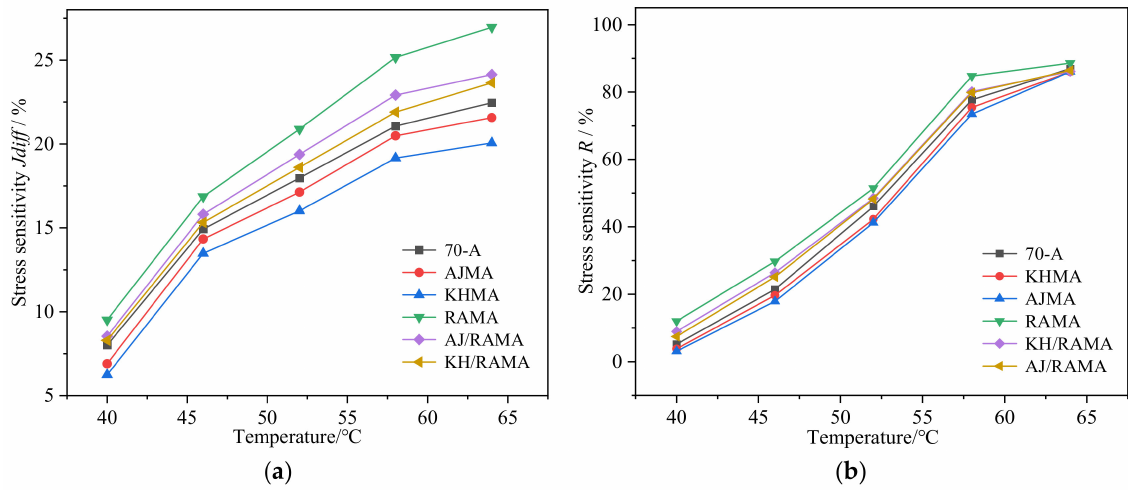
Figure 7. ( a ) Stress sensitivity J diff ; ( b ) Stress sensitivity R diff .